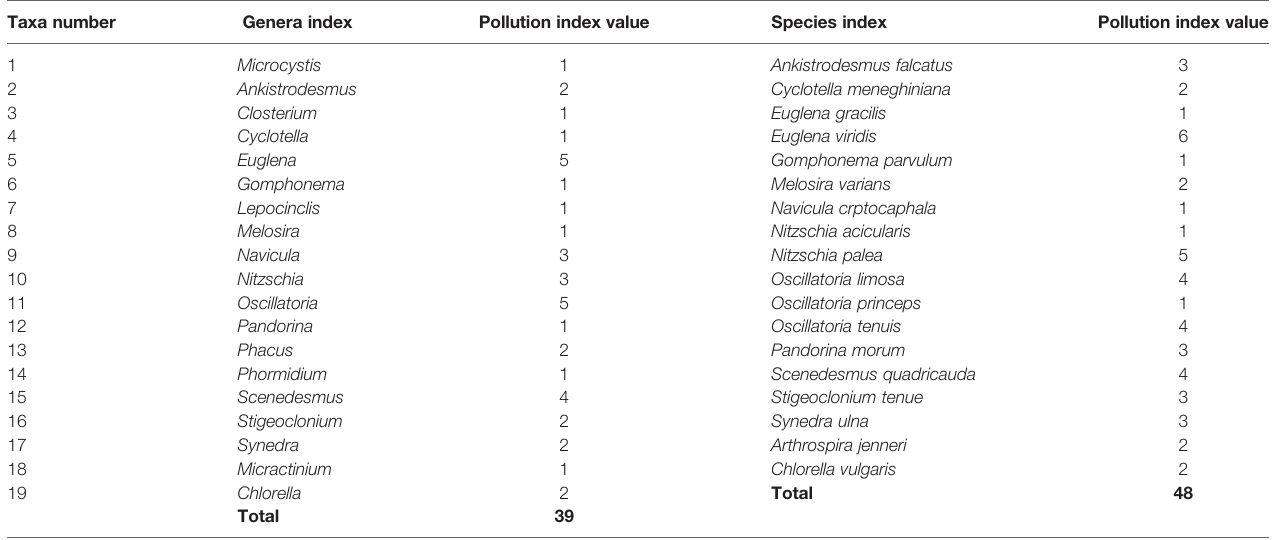
TABLE 3 | Algal Genera and species of pollution interest that are included in the Palmer, 1969 and were detected in the